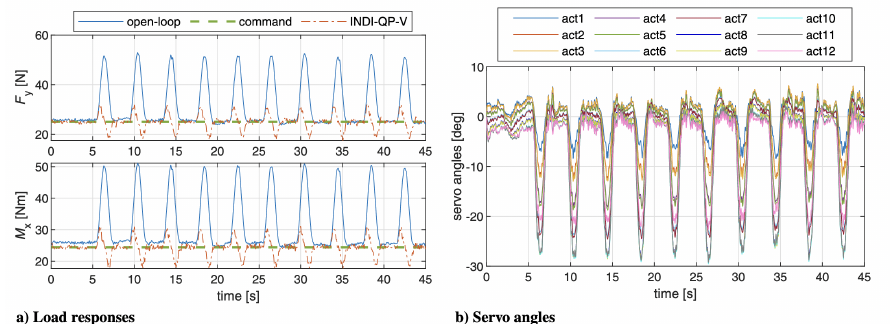
Figure 14. Dynamic load alleviation for ( a ) root shear force and root bending moment and ( b ) the required actuator settings for a 0.5 Hz gust